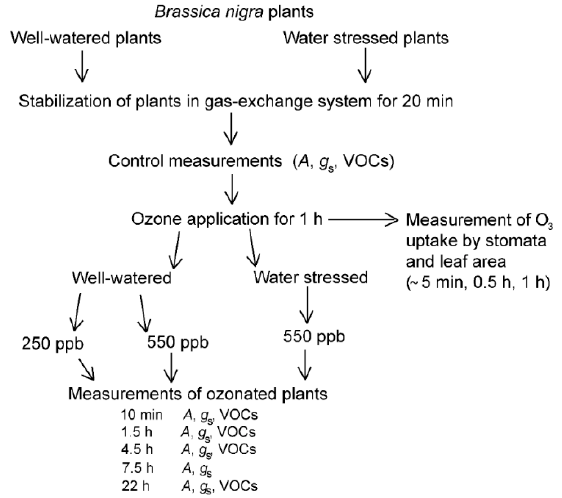
Figure 7. Scheme of studying ozone stress of well-watered and water-stressed plants of Brassica nigra . After measurements of photosynthetic characteristics and emissions of volatile organic compounds (VOCs) of control plants, well-watered B. nigra plants were treated with O 3 concentrations of 250 ppb and 550 ppb, while water-stressed plants were only exposed to 550 ppb. The exposure period was 1 h and O 3 uptake by stomata and leaf surface was recorded during the exposure. Photosynthetic characteristics were measured 10 min, 1.5 h, 4.5 h, 7.5 h and 22 h after O 3 stress. In the case of VOCs, measurements at 7.5 h were not conducted.